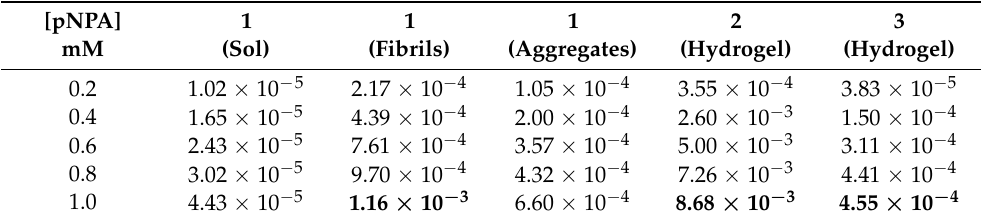
Table 2. Catalytic rates (k obs , s − 1 ) of peptides 1 – 3 on the hydrolysis of 4-nitrophenyl acetate (pNPA). The best performance for each peptide is indicated in